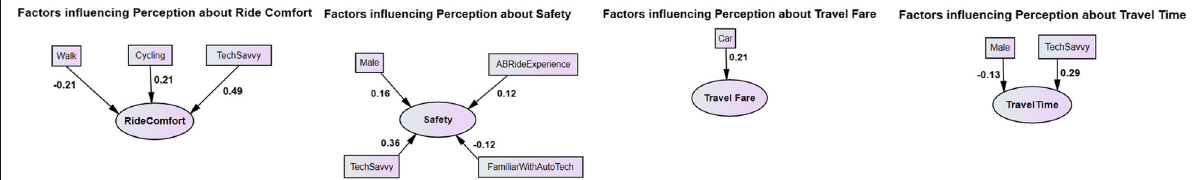
Fig. 6 Significant factors influencing service quality attribute perception (with p -value less than